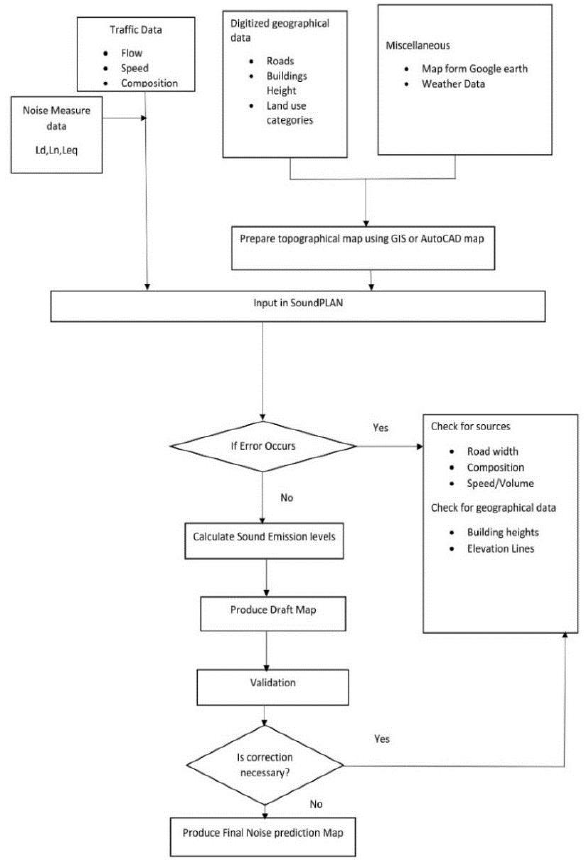
Figure 7: Methodology for noise